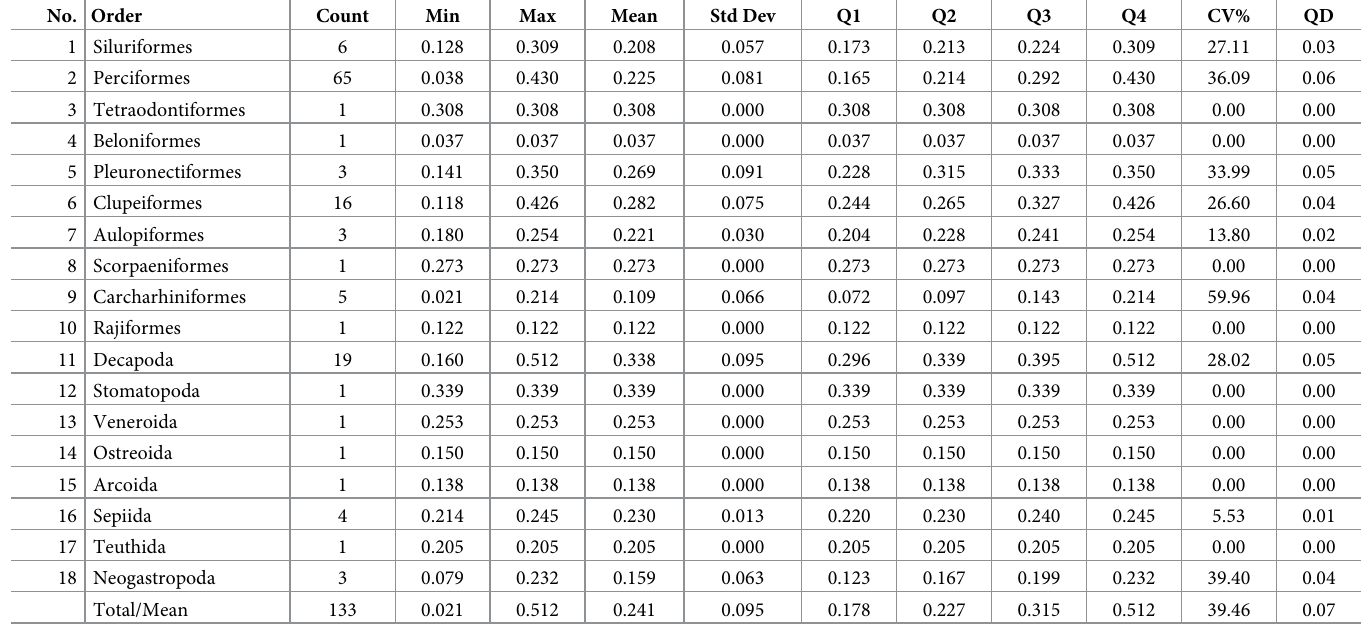
Table 6. Distribution of IRV scores by taxonomic order in the 133 species and their descriptive statistics. No.